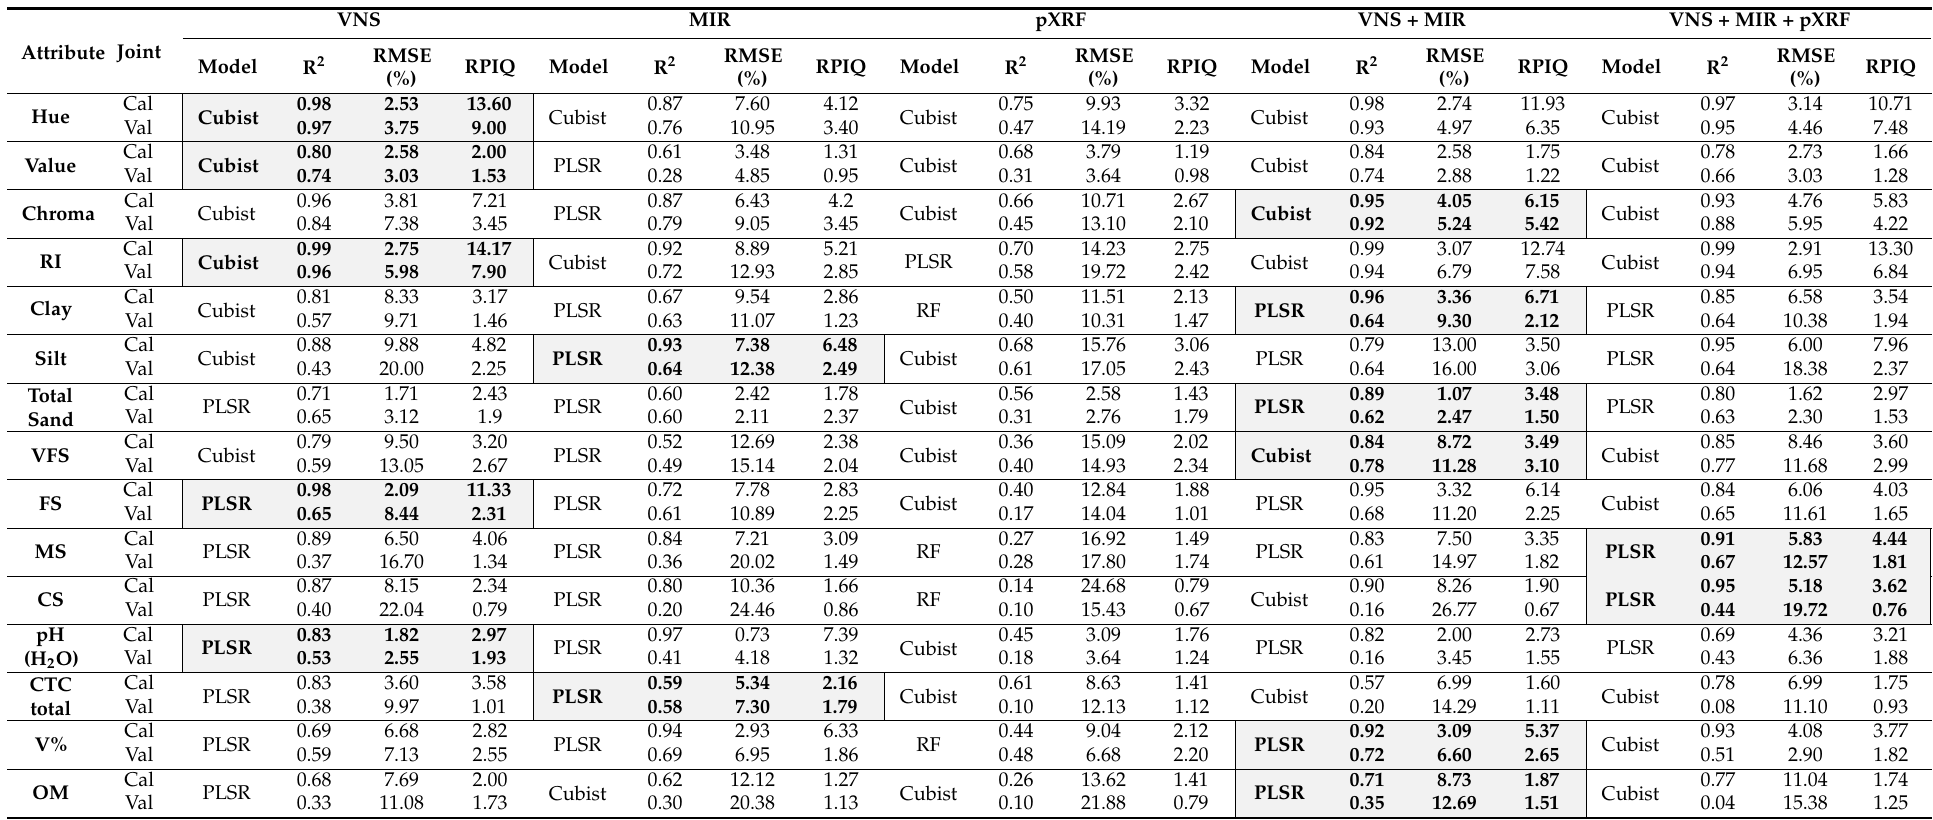
Table 1. Parameters from mathematical models for estimating soil attributes based on Vis-NIR-SWIR, MIR, and pXRF data (Cal: calibration; Val: validation; VNS: Vis-NIR-SIWR; R 2 : coefficient of determination; RMSE: root means error square; RPIQ: ratio of performance to interquartile distance; VFS, very fine sand; FS, fine sand; MS, average sand; CS, coarse sand; PLSR: “Partial Least Square Regression”; RF: “Random